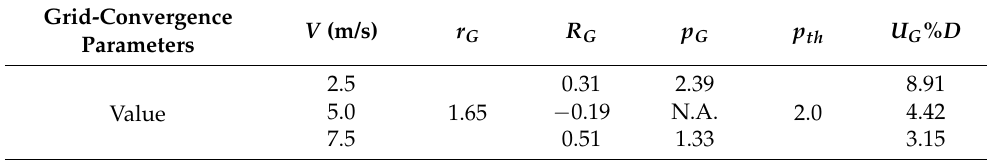
Table 4. Results for grid-convergence study.